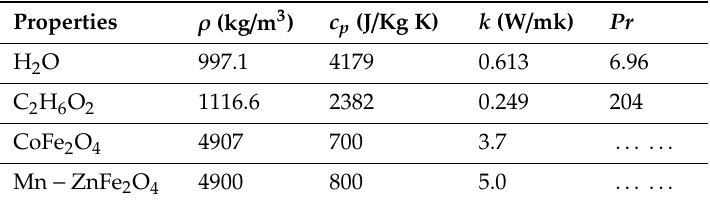
Table 1 escribes the thermal and physical characteristics for base liquids and nanoparticles. Table 1. Thermal and Physical characteristics